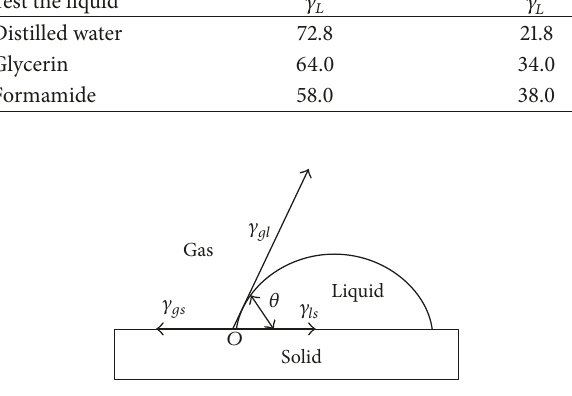
Figure 2: Young contact angle diagram.